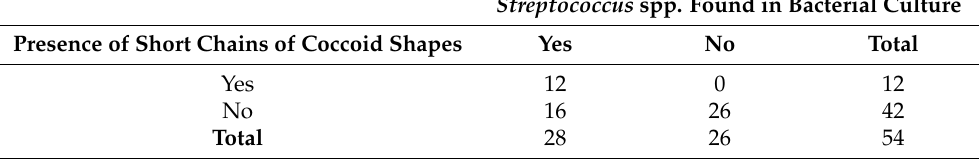
Table 4. Presence of short chains of coccoid bacteria (yes versus no) in a cytological smear of the leptomeninges in relation to the bacterial culture of the leptomeninges ( Streptococcus spp. present or not) *. Streptococcus spp. Found in Bacterial Culture Presence of Short Chains of Coccoid Shapes Yes No Total Yes 12 0 12 No 16 26 42 Total 28 26